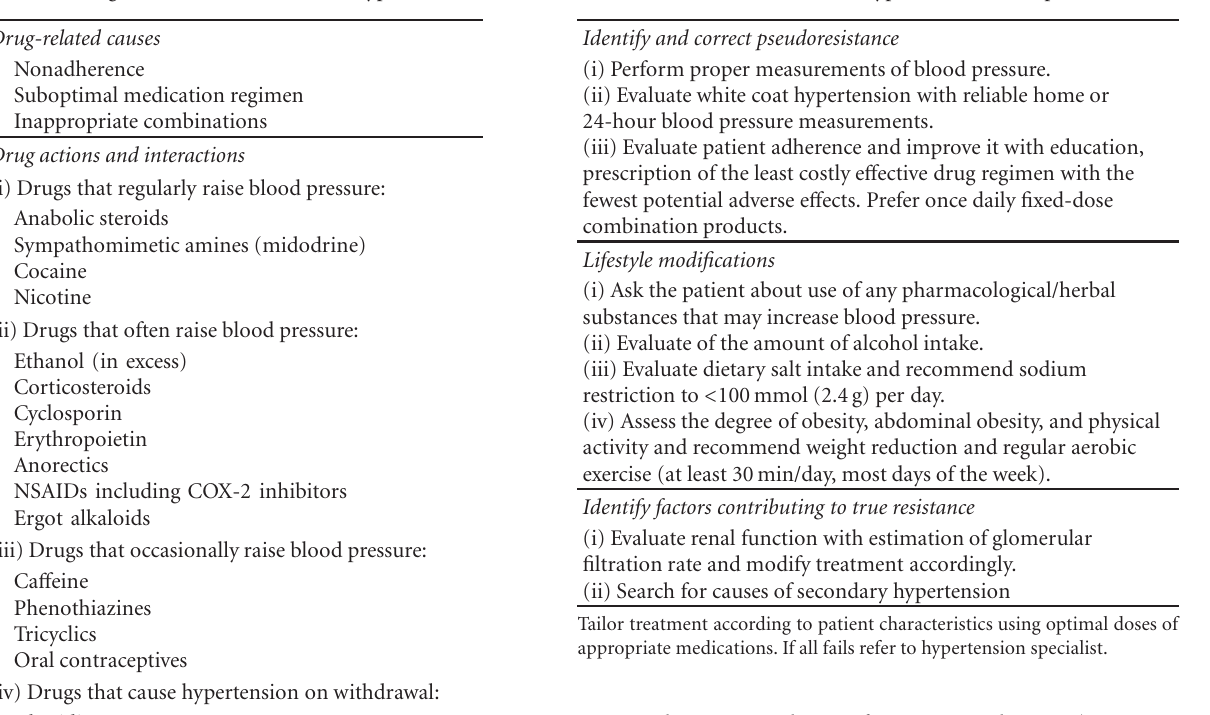
Table 2: Drug related causes of resistant hypertension. Table 3: Resistant hypertension